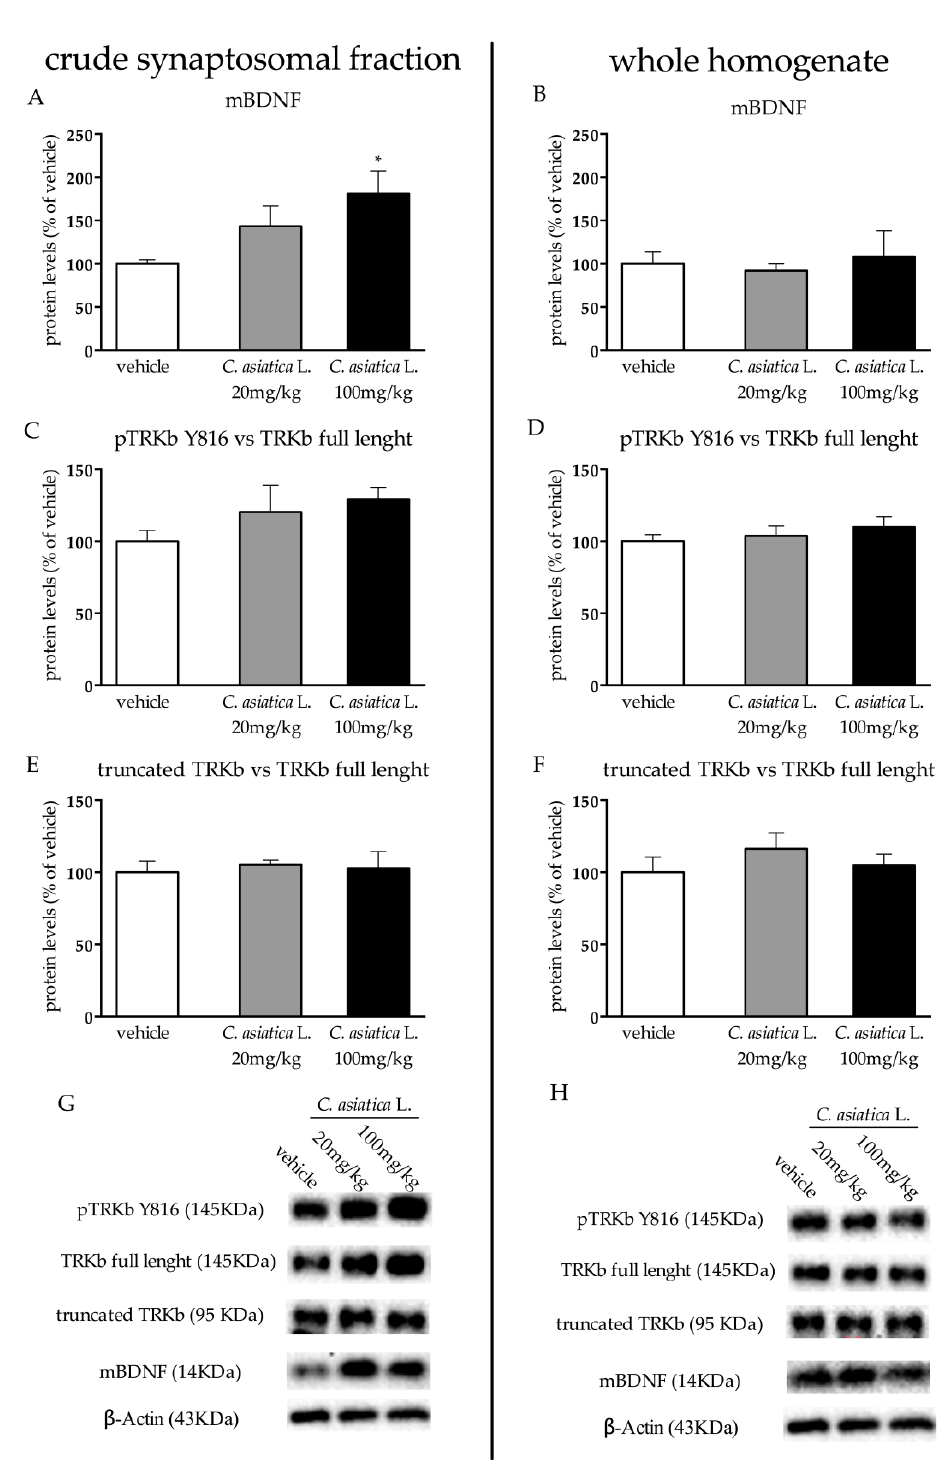
Figure 4. Analysis of mature brain-derived neurotrophic factor (mBDNF) ( A , B ), phospho tropomyosin receptor kinase B (TRKb) Y816 versus TRKb full length ( C , D ) and of truncated TRKb versus full length TRKb ( E , F ) protein levels in the crude synaptosomal fraction and in the whole homogenate of the prefrontal cortex of rats that were chronically treated with 20 or 100 mg / kg of C. asiatica L. Panels G and H represent the Western blot analyses of TRKb (pY816, full length and truncated) and mBDNF. β -Actin was used as an internal standard. The data are expressed as a percentage of the vehicle (set at 100%) and are represented as mean SEM of at least five independent determinations. * p < 0.05; vs vehicle (one-way ANOVA with Fisher’s